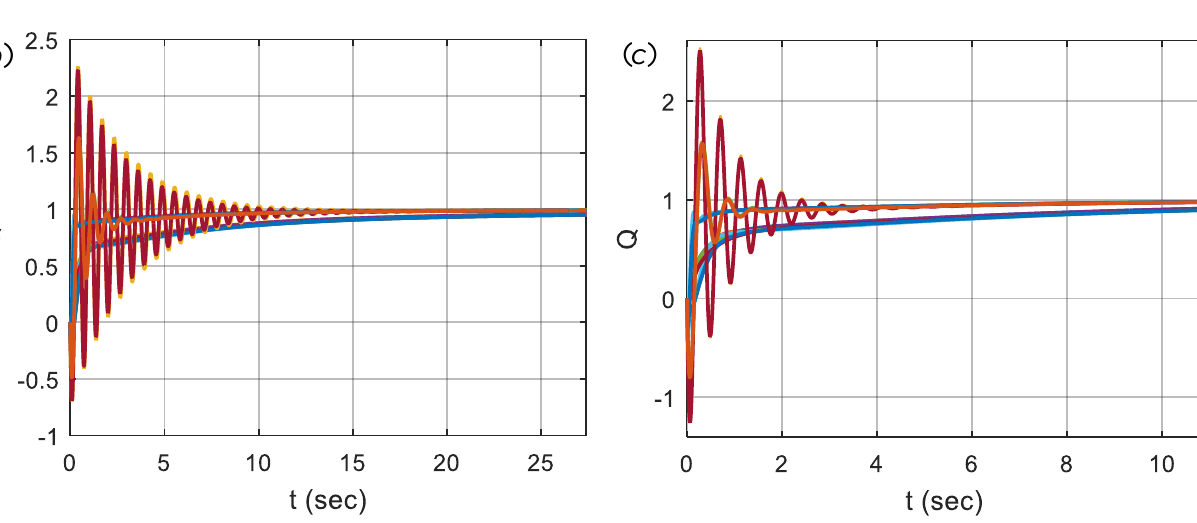
Figure 12. Step responses of 16 vertex plant functions for target angle specifications ( a ) for φ T 1 = 4 π ( c ) for φ T 3 = 7 π 80